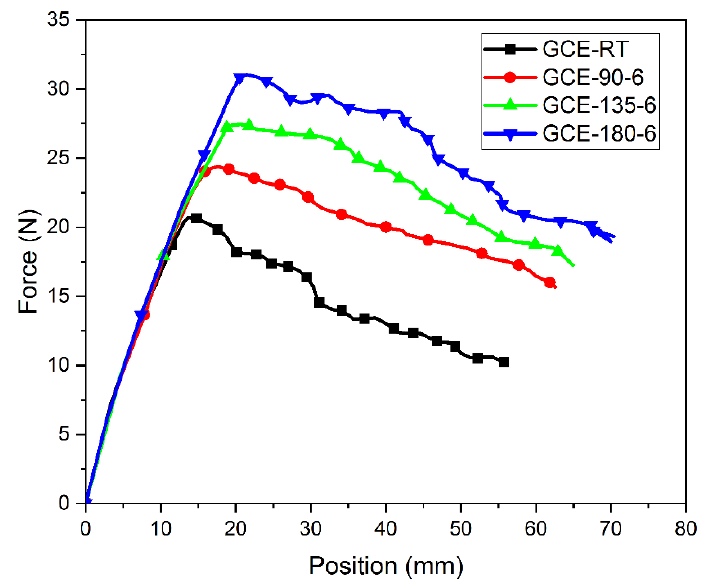
Figure 10. Load (P) versus Displacement ( δ ) plots from DCB tests of GCE laminates.